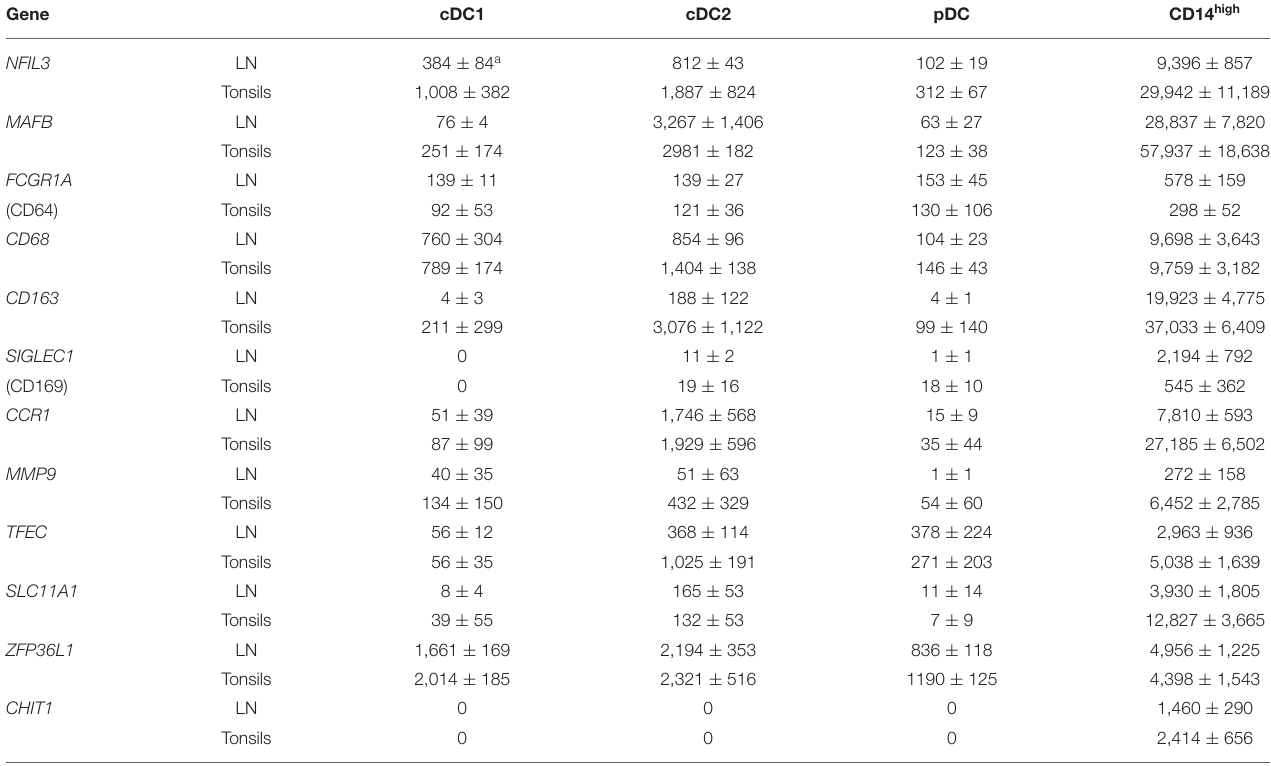
TABLE 5 | Differentially regulated genes in CD14 high cells. Gene